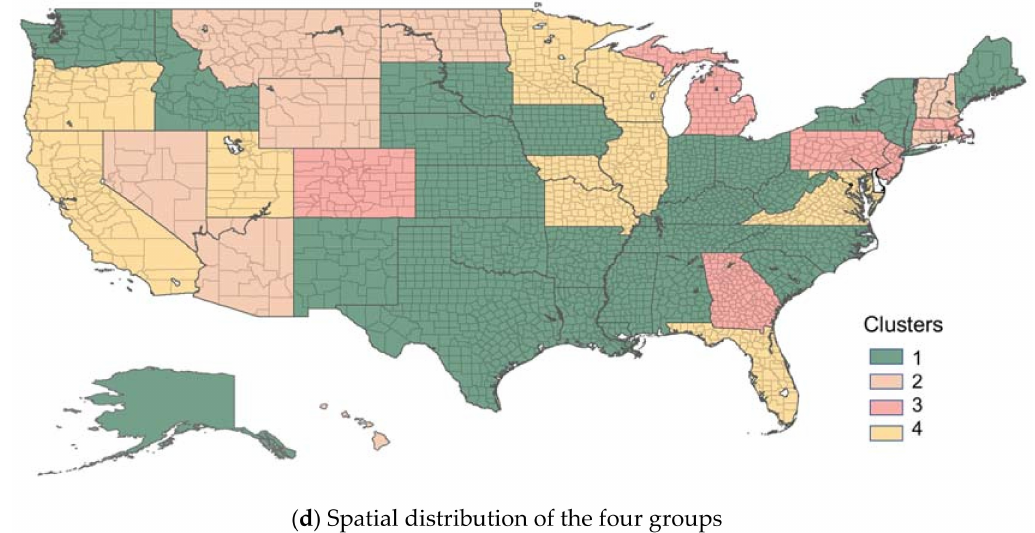
Figure 3. Time series of Moran’s I index for each state in the United States. The time series of the Moran’s I value from the 50th day were used for K -means clustering, as the values of most states were zero before the 50th day. ( a ) The AIC of the clustering algorithm achieved the minimum value when the number of clusters was four. ( b ) The four curves with grey ribbons represent the corresponding values and 95% CIs of the fitted lines of the four clusters. ( c ) The upper images show the original curves of the Moran’s I value, and the lower ones show the fitted trends and 95% CIs. ( d ) Most of the states belonged to Cluster 1, while Cluster 2 was mainly located in the middle. Although the states in Cluster 3 were dispersed, Cluster 4 displayed a pattern of spatial aggregation.